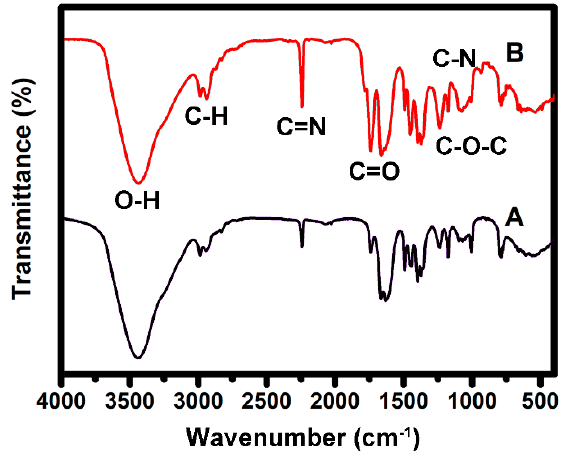
Figure 5. FTIR spectra of ( A ) PAN and ( B ) PAN/GO/DCDMH.